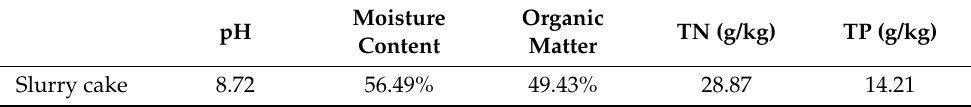
Table 2. The primary properties of the semi–drying slurry cake after biological coagulation dewater- ing